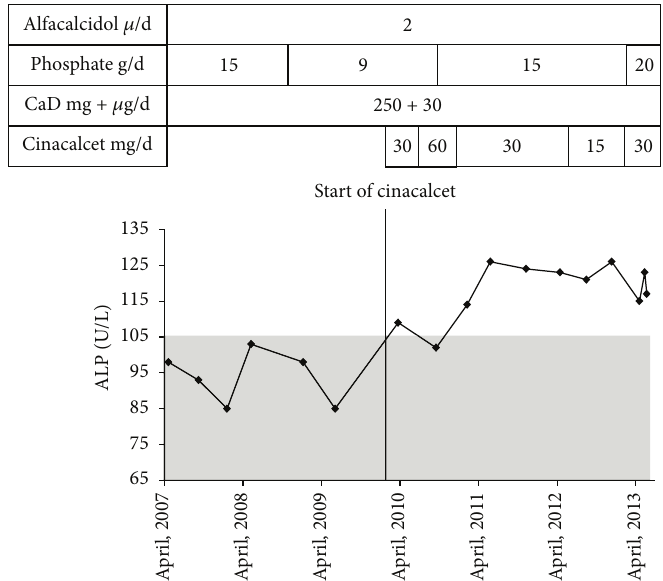
Figure 2: Plasma levels of alkaline phosphatase three years before initiation of cinacalcet treatment and during the three years of cinacalcet treatment. Start of cinacalcet treatment, as indicated by the vertical line, was March 2010. Top bars show dosage of medical treatment. CaD; calcium carbonate 250 mg with 30 𝜇 g/d (1200IU) of cholecalciferol. The reference interval of plasma alkaline phosphatase was 35–105 U/L as indicated by the grey